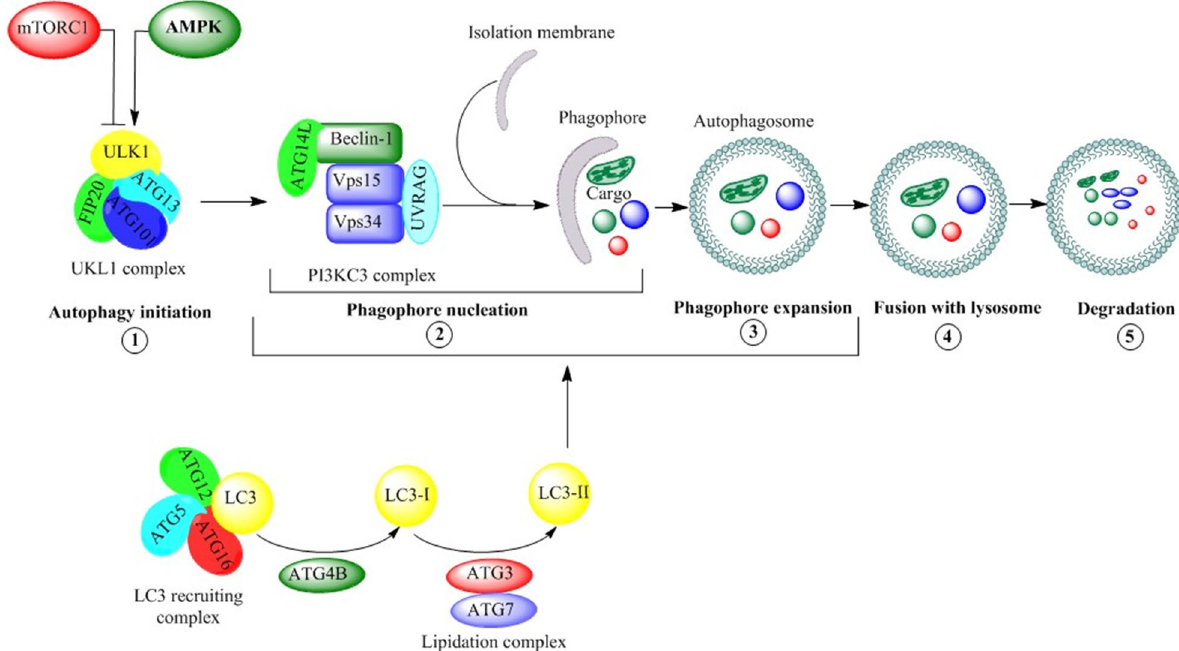
Fig. 1 The schematic view of the role of NEDD4 E3 ubiquitin ligases in the autophagic process in cancer